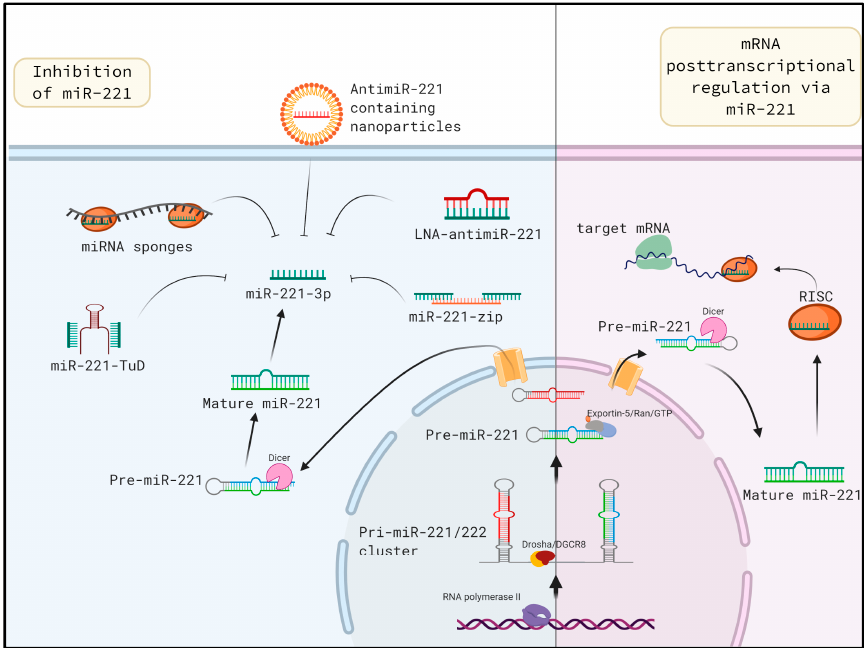
Figure 2. Biogenesis of miR-221 is shown on the right side of the figure. The pri-miR-221/222 cluster is first generated and then processed into pre-miR-221 and pre-miR-222 in the nuclei. Upon translocation of pre-miR-221 from the nuclei to the cytoplasm, Dicer mediates another processing to generate miRNA duplex. One of the strands may be incorporated into RISC complex to regulate gene expression at the posttranscriptional level. On the left side of the schematic, multiple approaches of in vivo miR-221 inhibition are shown. MiR-221 can be inhibited via sponges, antimiR containing nanoparticles, TuDs, miR-zips and LNAs. Each method has been shown to be effective in miR-221 in vivo inhibition. Due to miR-221 inhibition, amelioration of liver fibrosis and attenuation of HCC development was observed.